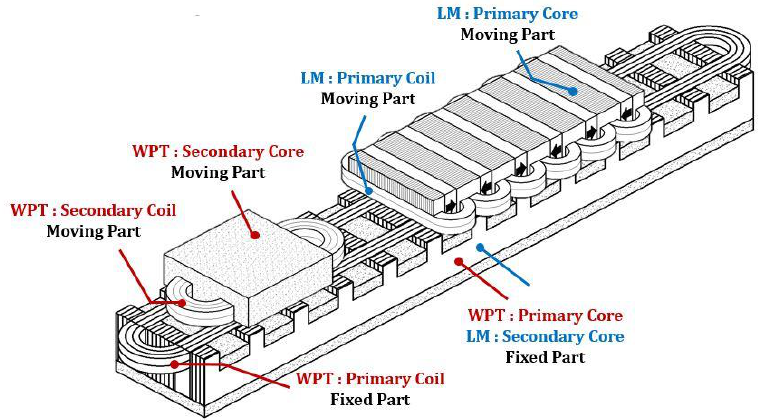
Figure 2. Geometry of the integration system with WPT and LM.